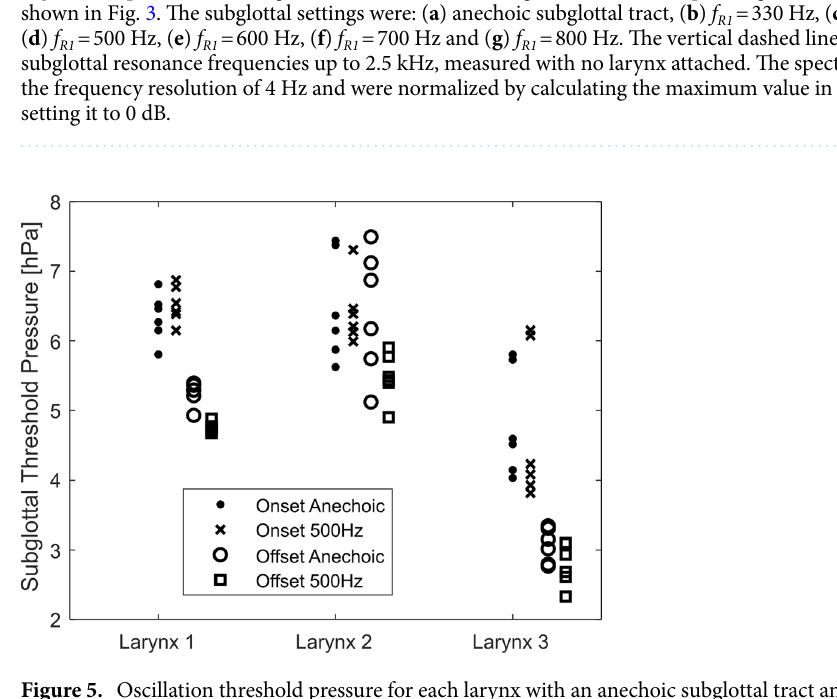
phonation onsets and offsets, the larynges exhibited irregular vocal fold vibrations, therefore we did not include these parts of the signal in the f o analysis. Only the parts with a stable f o were kept for analysis. For given mean subglottal pressures, the SPL of the subglottal sound was found to be higher when using the resonant tract, as shown in Fig. 7a–c. At the mean subglottal pressures above 8 hPa, the difference in SPL was about 6–8 dB for the first larynx, 2–3 dB for the second larynx and 4–5 dB for the third larynx. In both the anechoic and resonant cases the subglottal SPLs showed extremely high values reaching up to 150 dB re 20 µPa.